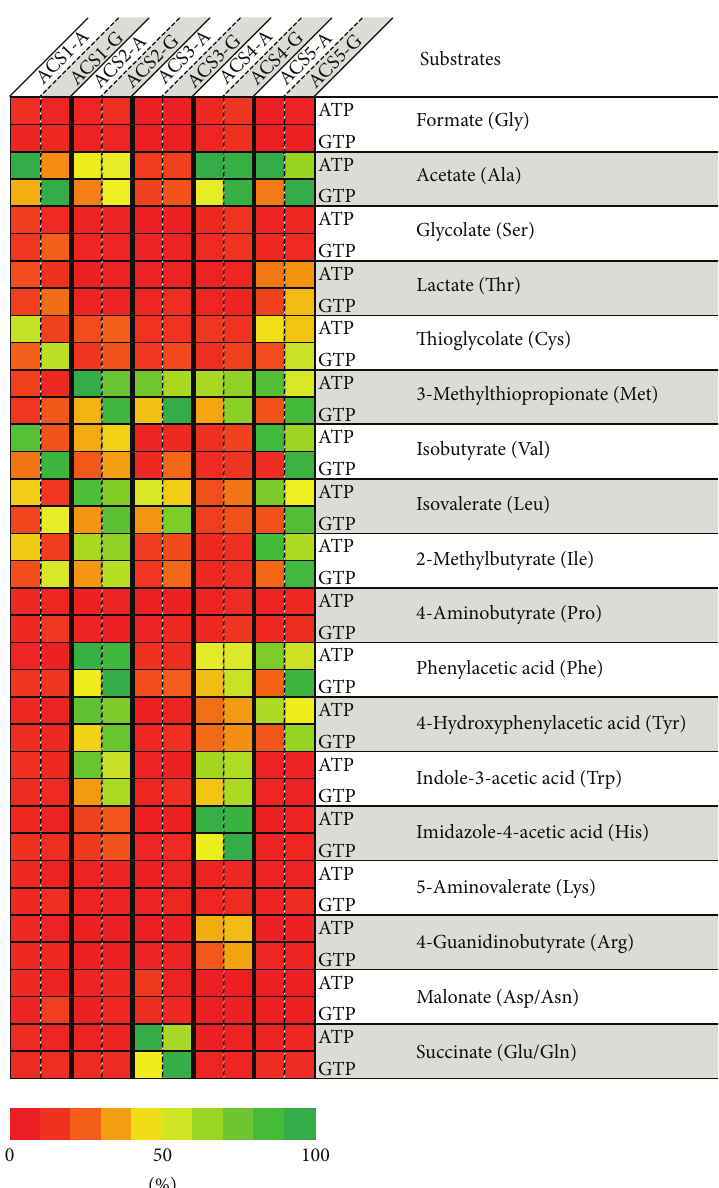
Figure 2: Heat map of activities of the ten ACS isoenzymes with eighteen organic acids with ATP or GTP. 100% activity corresponds to the highest activity of an individual enzyme with ATP or GTP. All other activities in a given column are relative to the highest value.